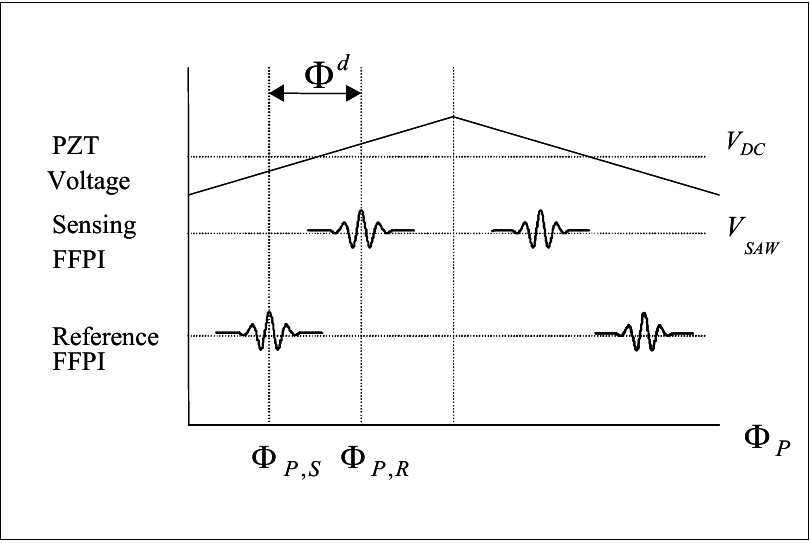
Figure 2 . Output of sensing and reference FFPI from